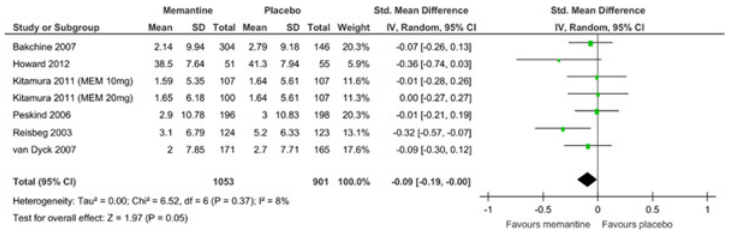
Fig 5. Forest plot of activity of daily living (7 comparisons, n = 1954). * Negative SMD values favor memantine; positive SMD values favor placebo. † RR < 1 favors memantine; RR > 1 favors placebo.